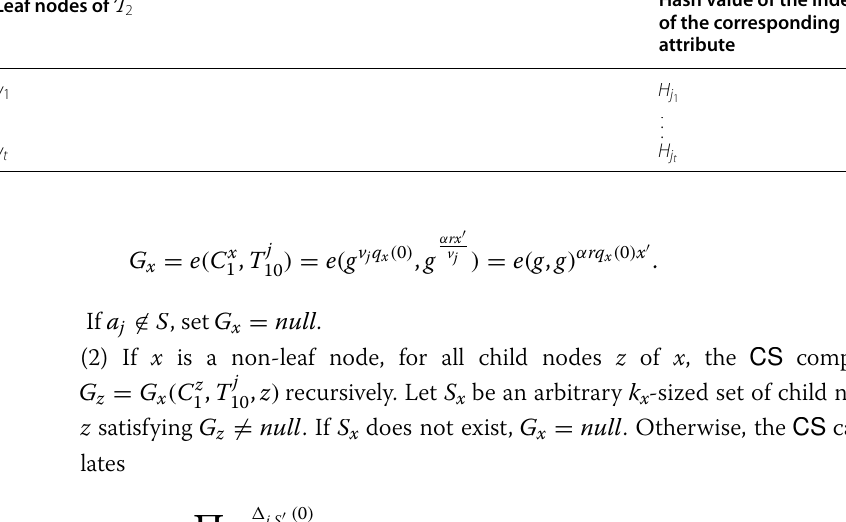
Table 2 Correspondence between leaf node and attribute index Leaf nodes